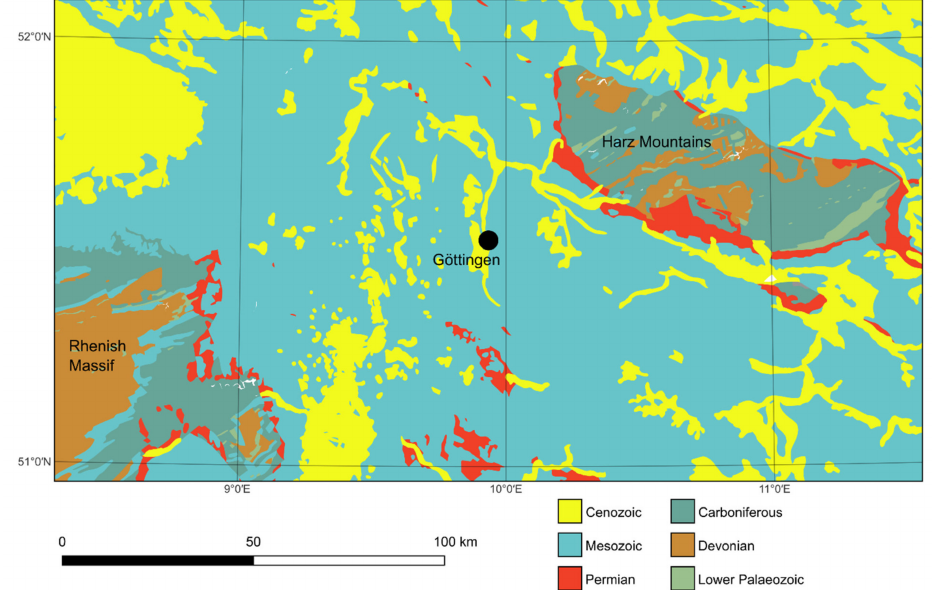
Figure 1. Geological map showing the location of the Harz Mountains, where the exposed De- vonian and Carboniferous rocks are used as an analogue for a proposed EGS at Göttingen. Ad- ditionally, shown is the Rhenish Massif, which also shows exposures of Devonian and Carbonif- erous rocks. Göttingen along strike of the Variscan belt between the Harz Mountains and the Rhenish Massif. The dominant lithologies are as follows. Lower Palaeozoic, Devonian and